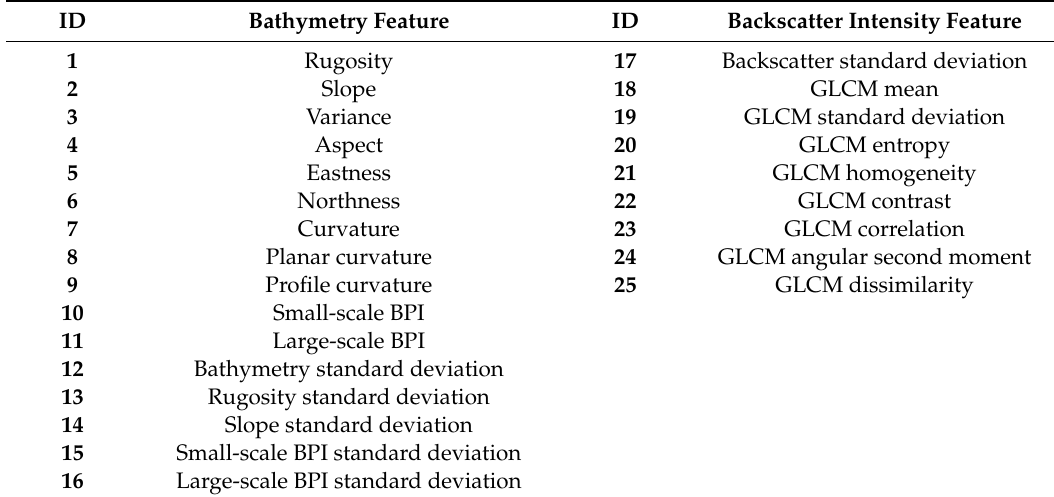
Table 1. List of bathymetry and backscatter intensity features extracted in this study. BPI—bathymetric position index; GLCM—grey-level co-occurrence